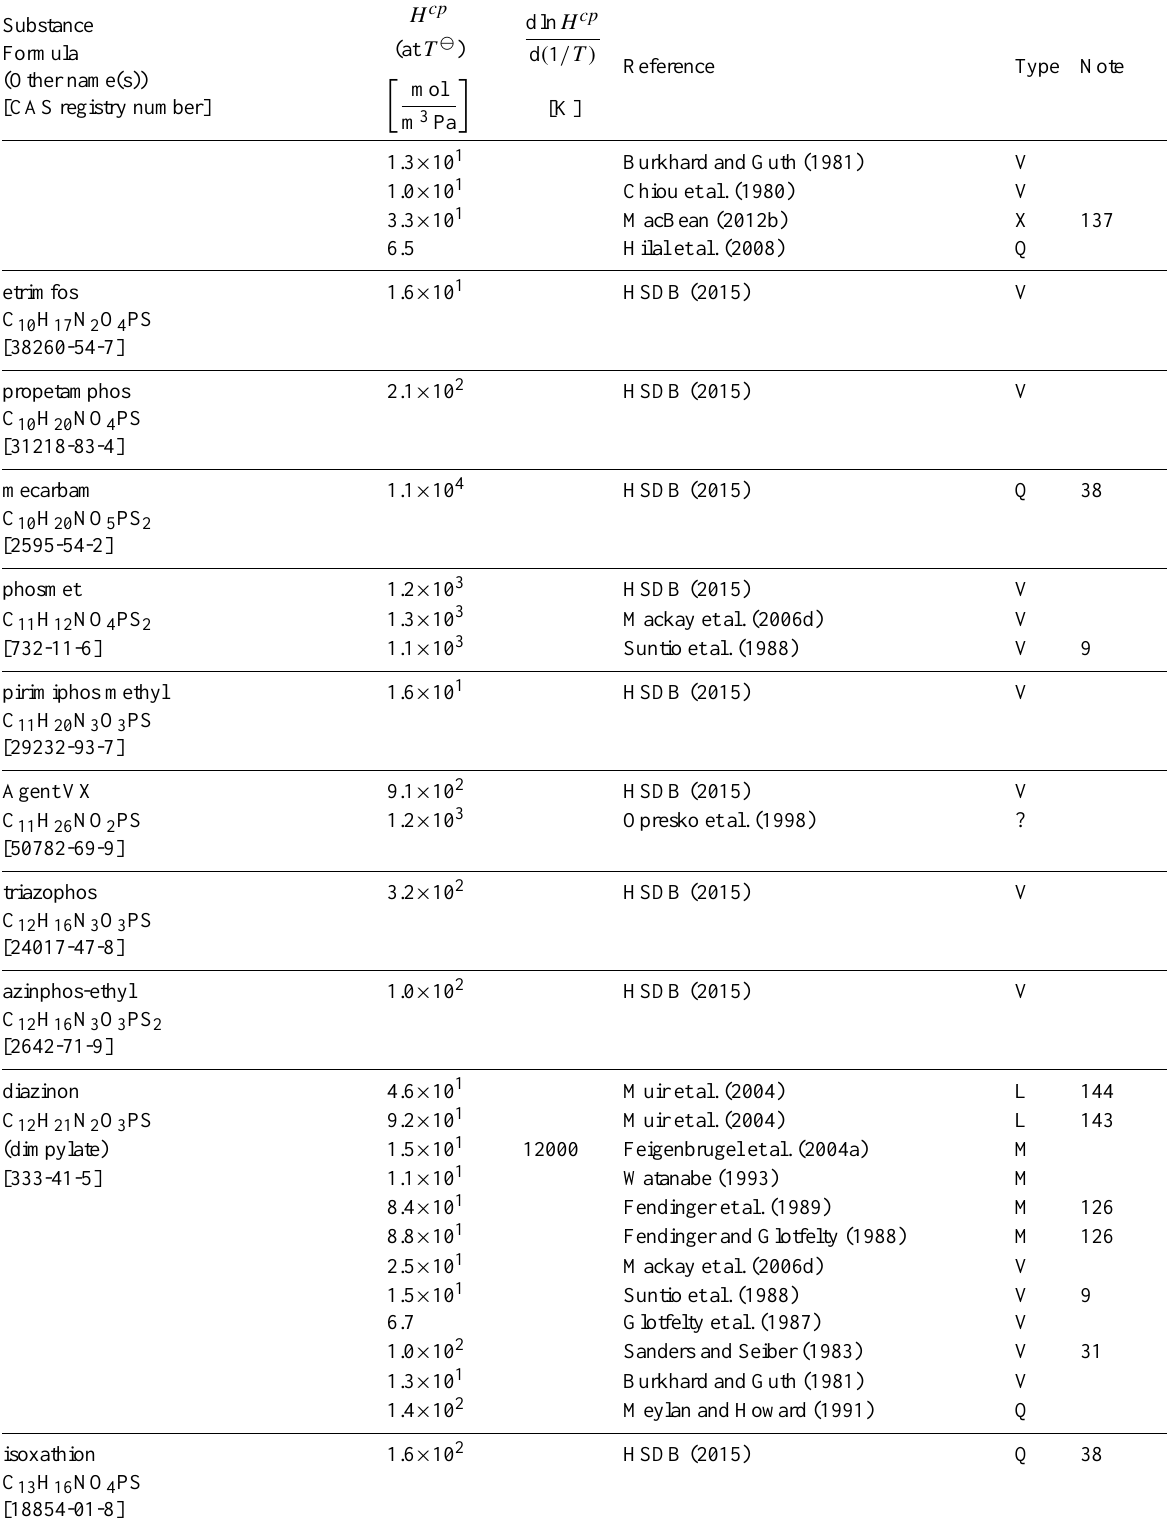
Table 6: Henry’s law constants for water as solvent